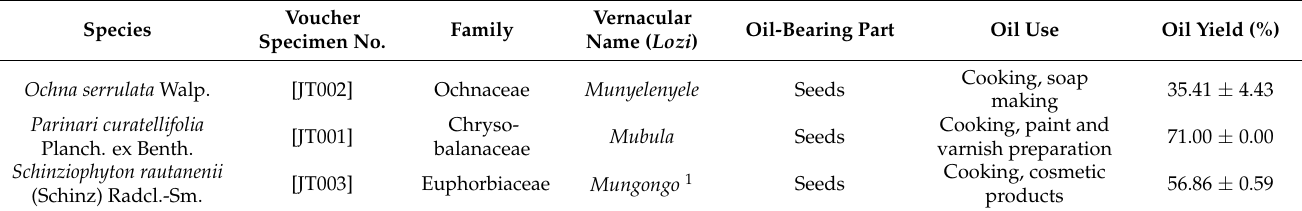
Table 1. General information and oil yields of the tested oil plants.